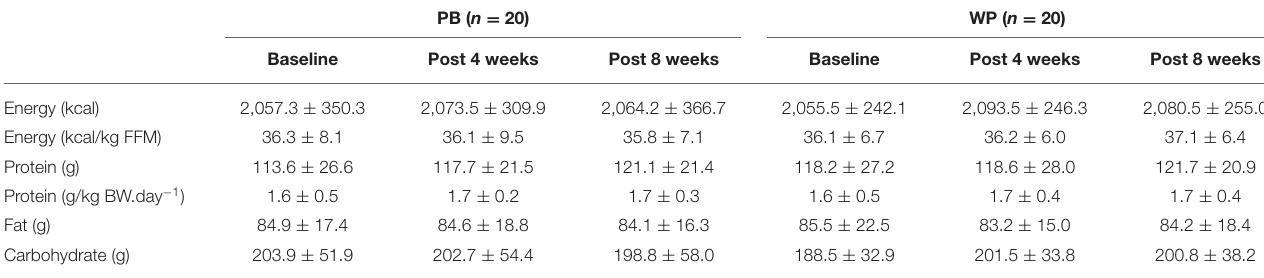
TABLE 2 | Energy and macronutrient intake at baseline and after 8 weeks of intervention.